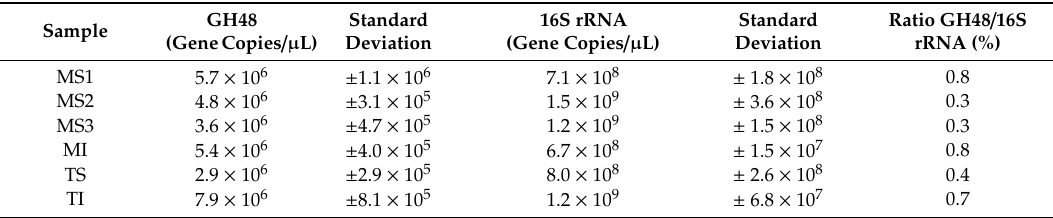
Table 3. GH48 and 16S rRNA gene copy numbers quantified in DNA isolated from raw digestate samples of biogas fermenters.